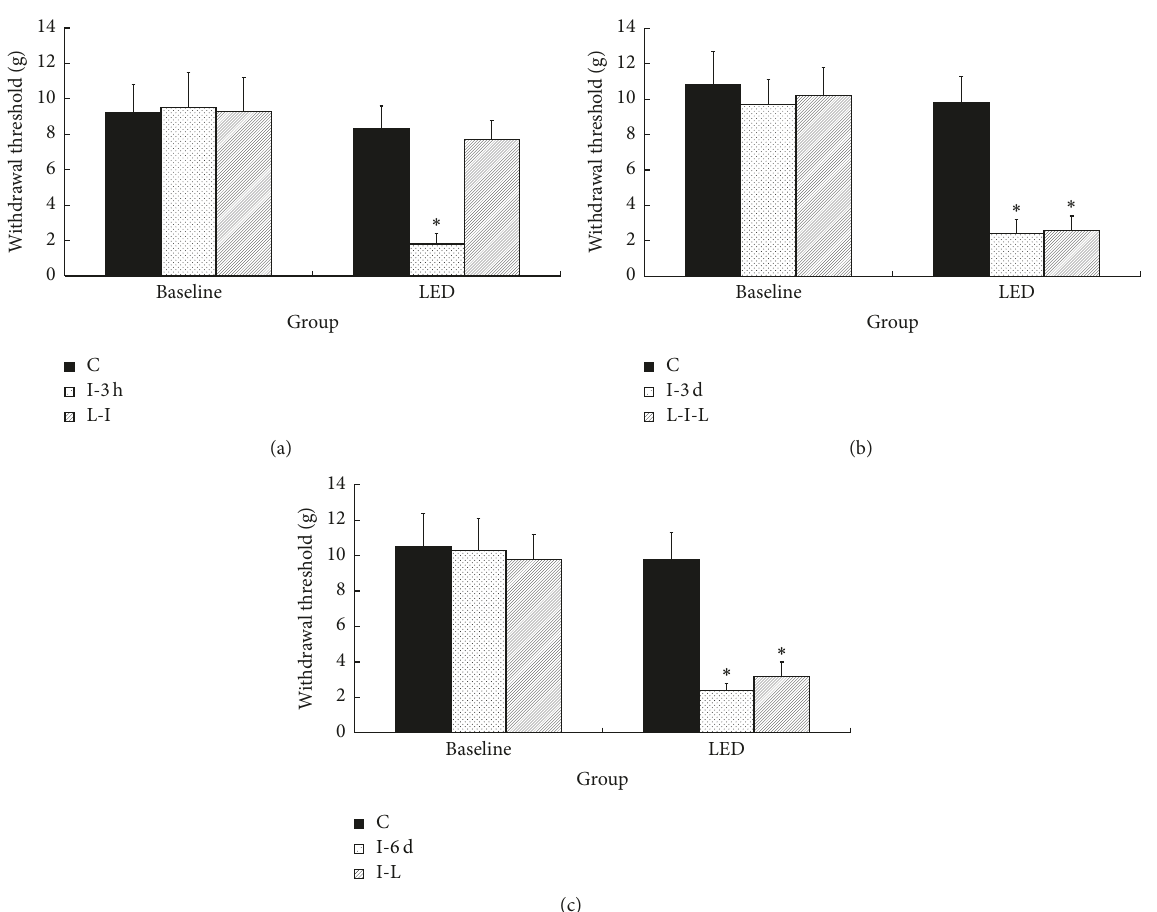
Figure2:Meanwithdrawalthresholdinthesixgroups( 𝑛 = 6 eachgroup)6daysafterLEDirradiationperformedbeforeorafterskinincision. C indicates LED irradiation for 6 days before or after sham skin incision on the paw contralateral to the LED-irradiated incised paw; I-3h, I-3d, and I-6d indicate incision only groups that underwent behavioral testing 3 hours, 3 days, and 6 days after skin incision; L-I indicates LED irradiation for 6 days before skin incision; I-L indicates LED irradiation for 6 days after skin incision; L-I-L indicates LED irradiation from 3 days before skin incision to 3 days after skin incision. ∗ 𝑝 < 0.05 compared with the baseline value in each group. The values represent the means ±